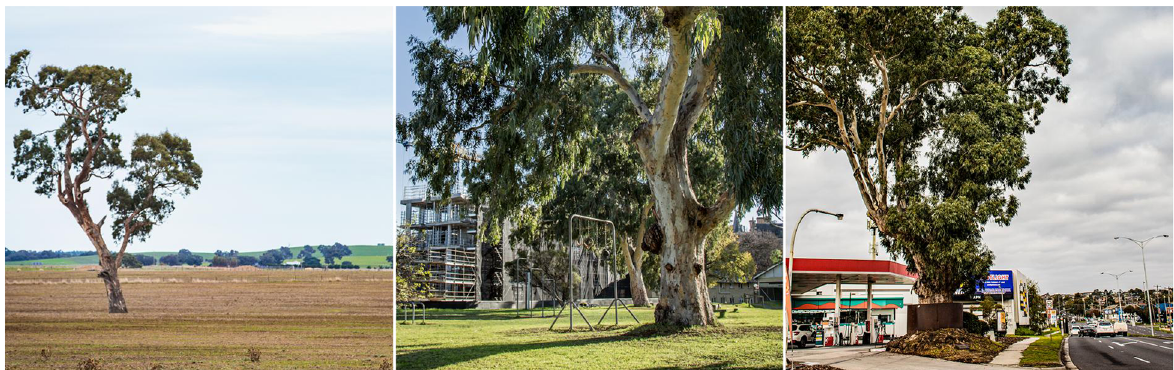
Fig. 2 Tree context. Left: a river red gum ( Eucalyptus camaldulensis ) within managed agricultural land. Middle: a river red gum in an urban park. Right: a river red gum among paved surfaces (Source: the